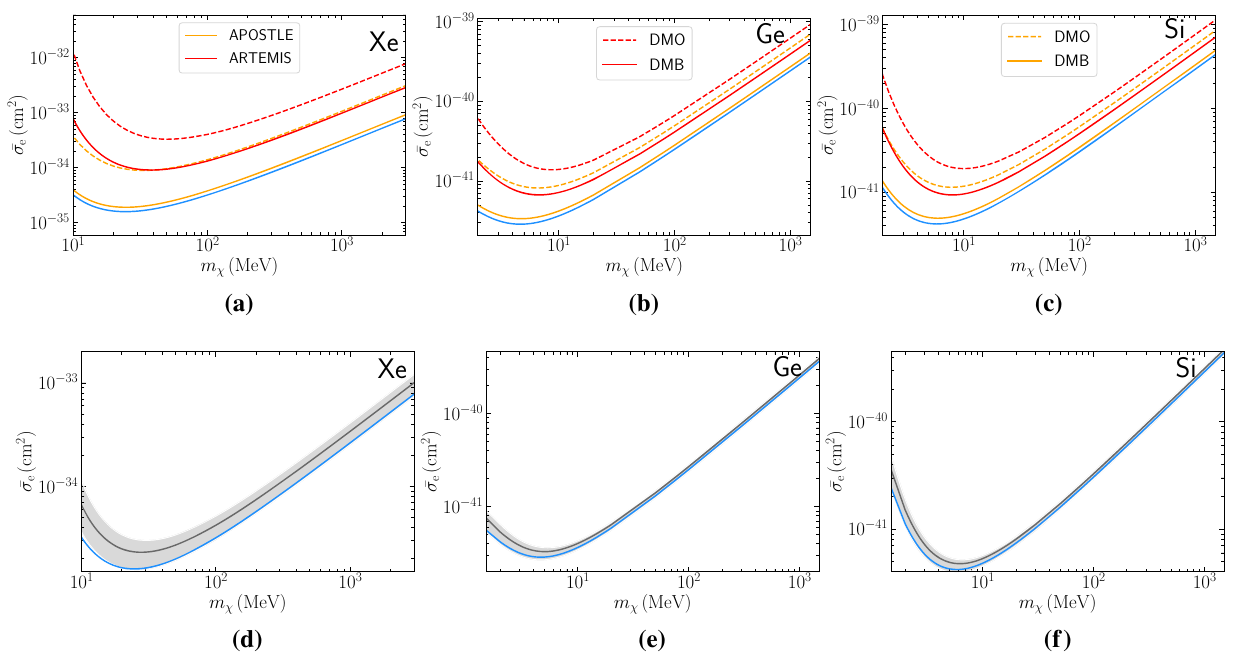
Fig. 16 Same as Fig. 15 but for F DM ∝ q − 2